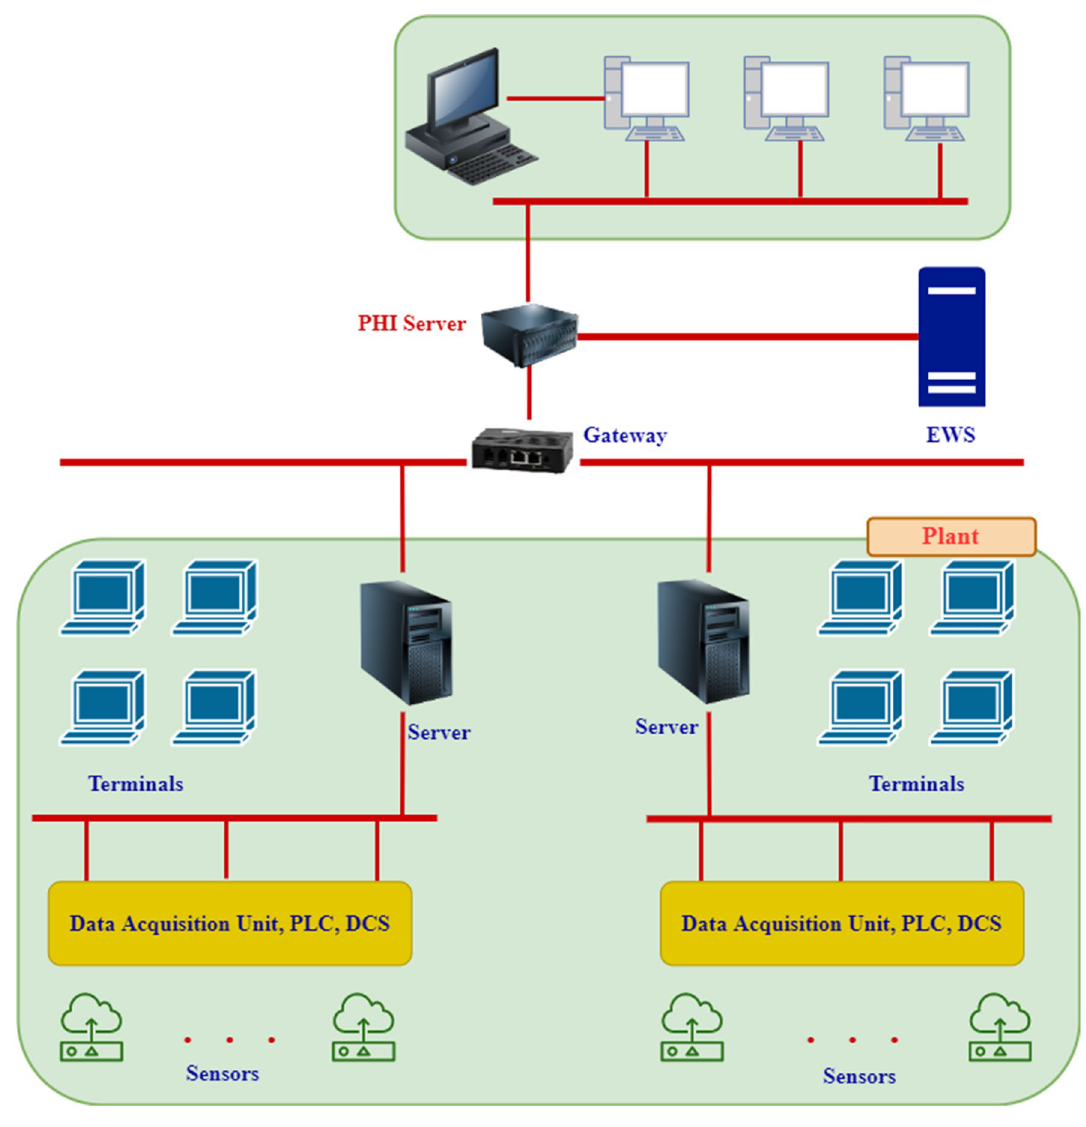
Figure 13. PHI System implementation